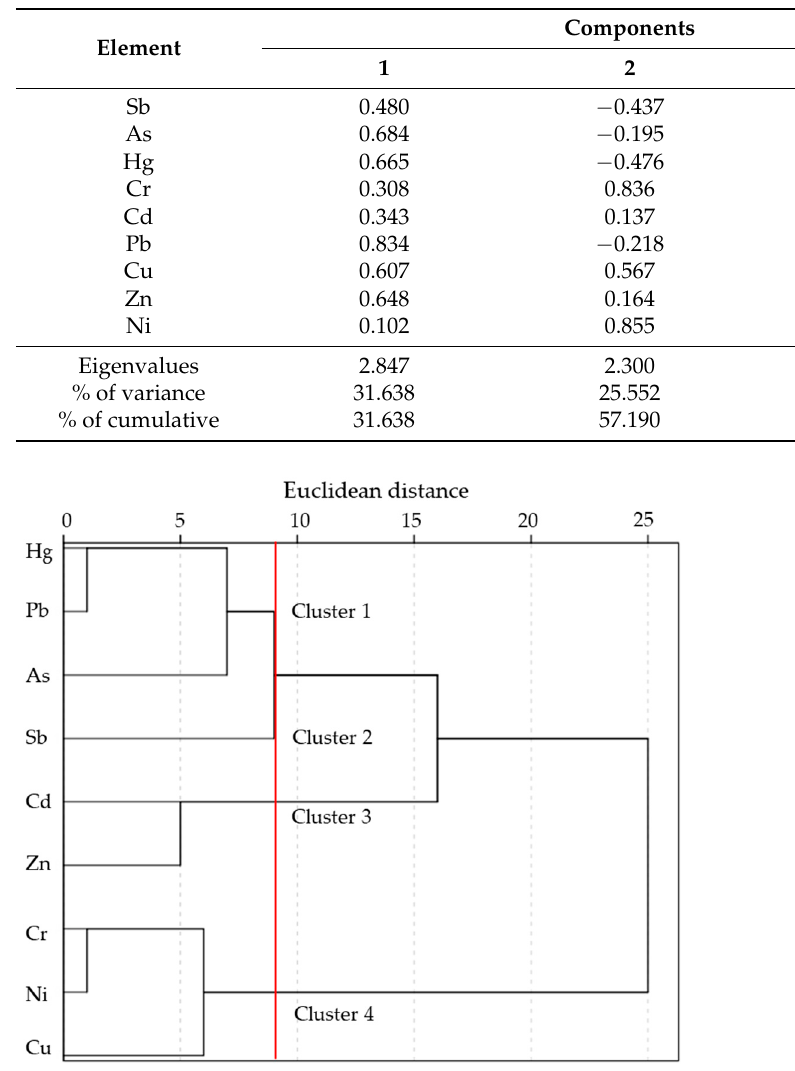
Table 3. Rotated component matrix of heavy metals by PCA.